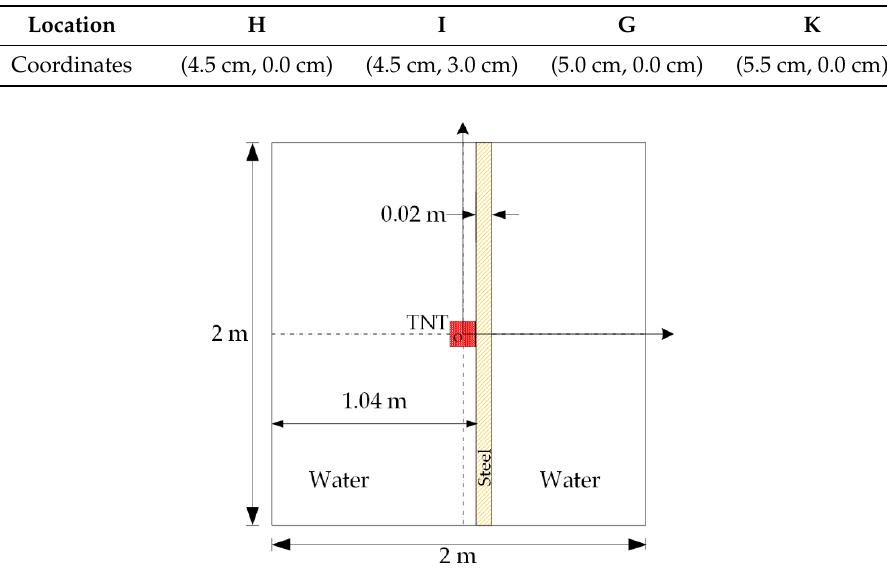
Table 4. The locations of two viewpoints for example2.